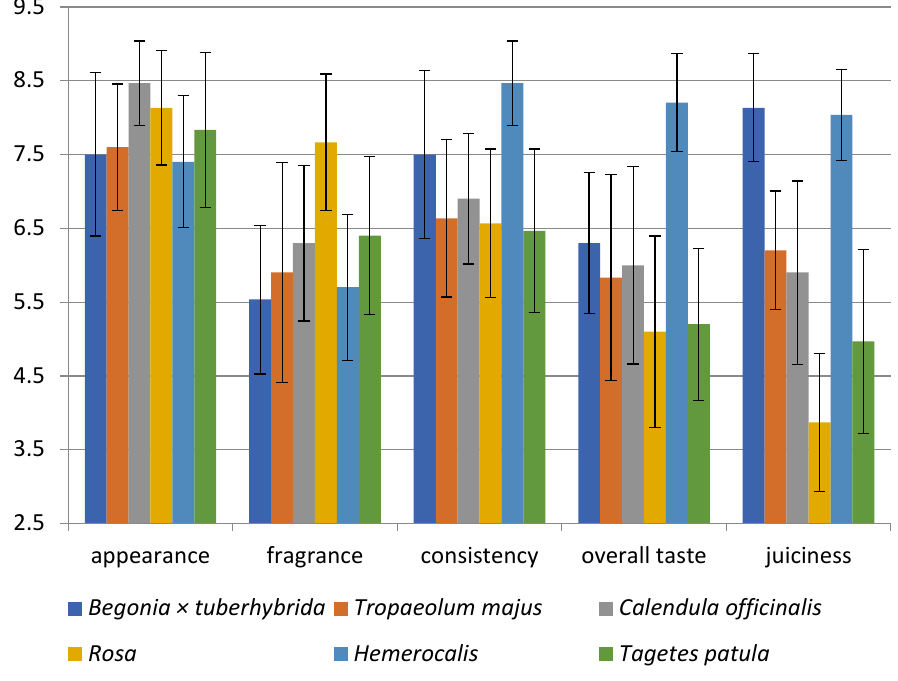
Figure 1. Sensory analysis diagram for six edible flowers; Begonia × tuberhybrida ; T. majus ; C. officinalis ; Rosa ; Hemerocallis ; T. patula .